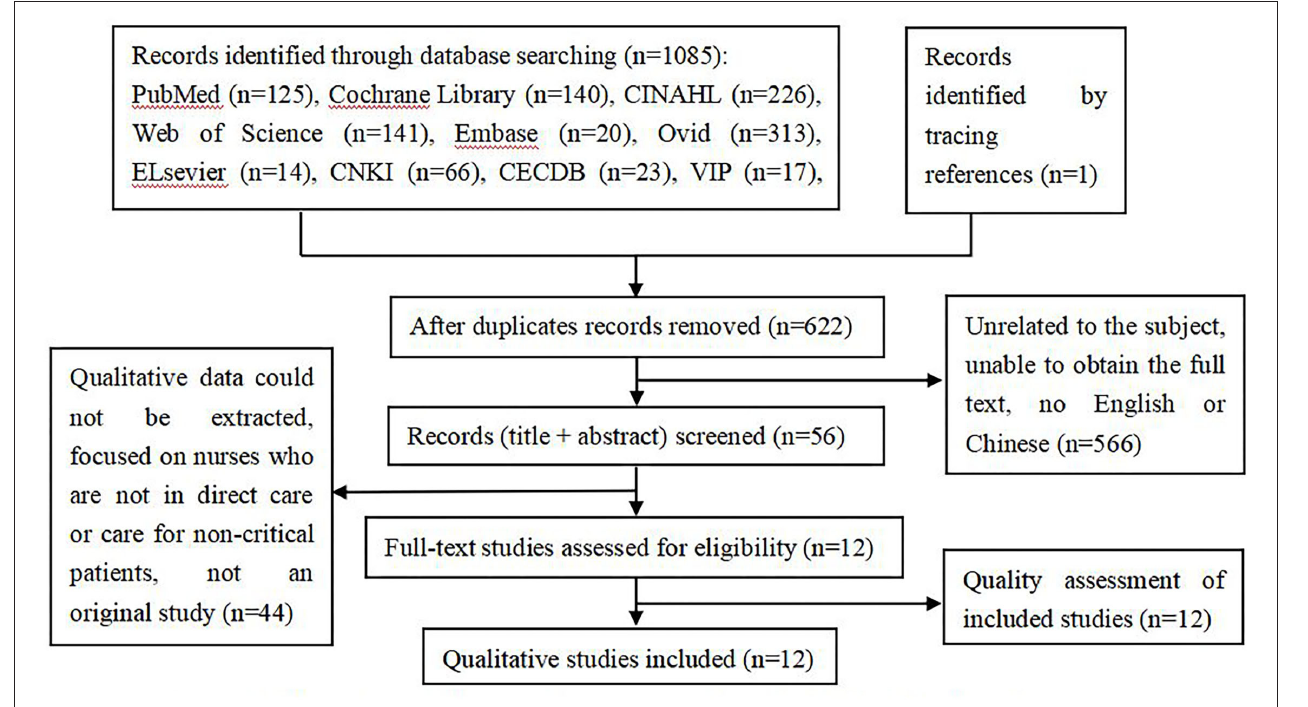
FIGURE 1 | Flowchart of the search strategy and results (PRISMA flow